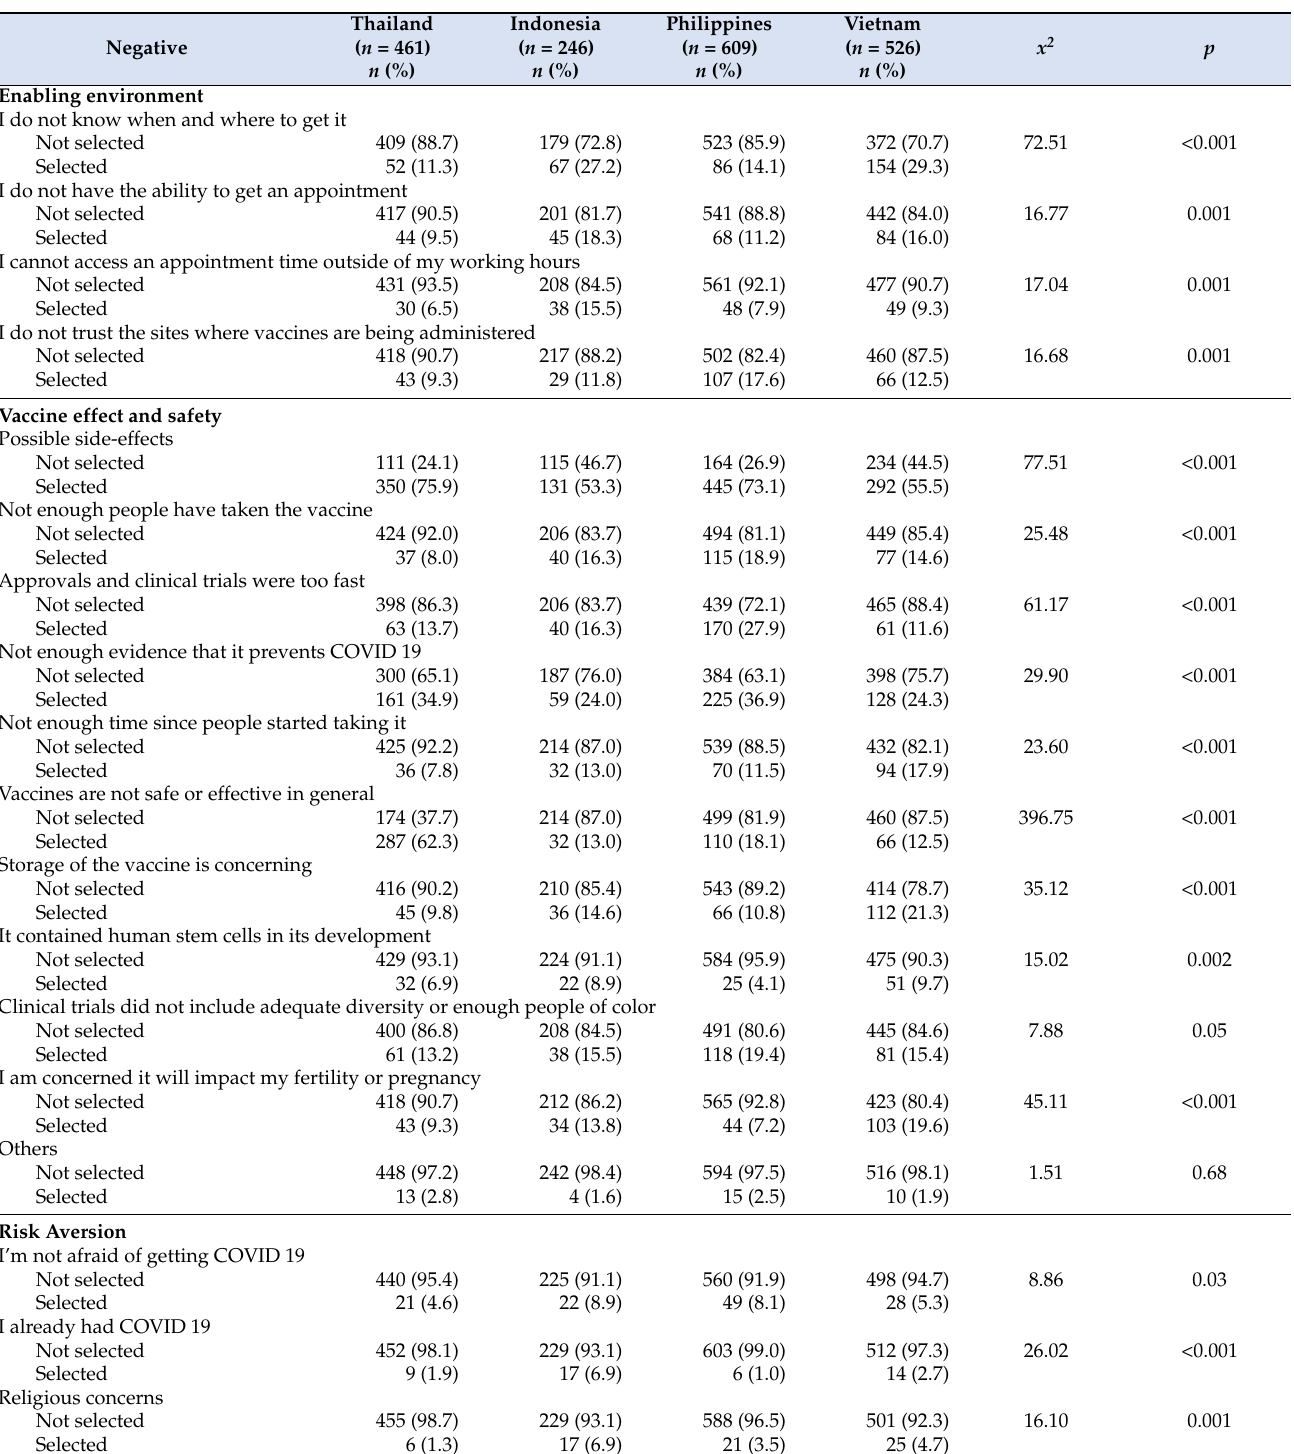
Table 7. Negative reasons (factors) for